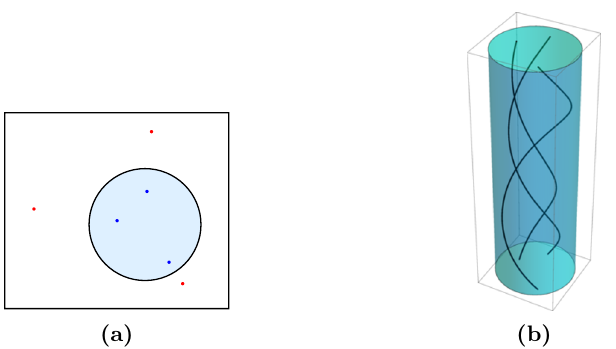
Figure 3 . (a) An insertion of three chiral CFT operators in the unit disk (blue dots) and in their image points on the plane (red dots) corresponds (b) to a con(cid:12)guration of three spinning particles moving on helical geodesics in Lorentzian AdS 3